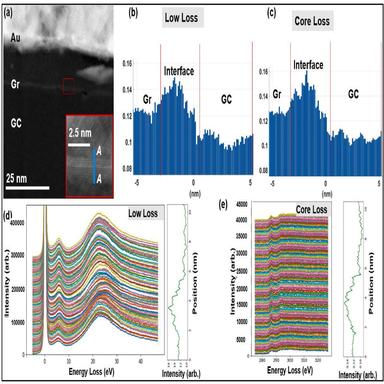
(a) HAADF image of the GrGC material (b) low-loss HAADF spectrum (c) core-loss HAADF spectrum. EELS recorded along section A-A of (d) the low-loss region and (e) core-loss region. The STEM ADF intensity is shown on the right. Note that section A-A is taken through the depth. (A colour version of this figure can be viewed online.)